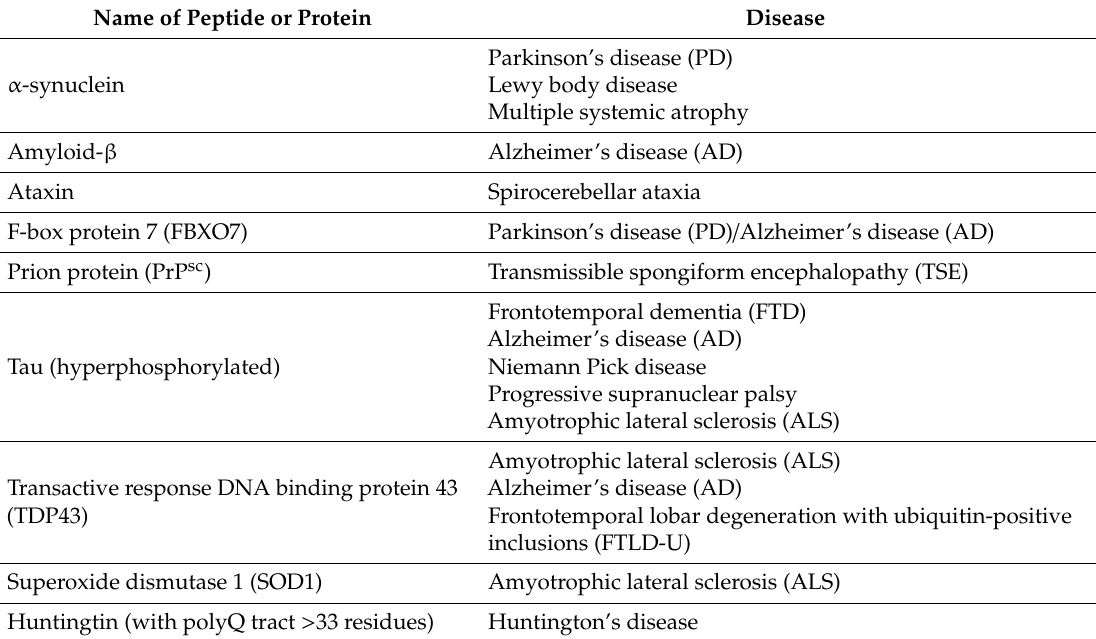
Table 1. Human amyloidoses with manifestation in the central nervous system (neurodegenerative disorders). While some proteins / peptides represent a characteristic hallmark for just one disease, some are also found in various diseases such as hyperphosphorylated Tau